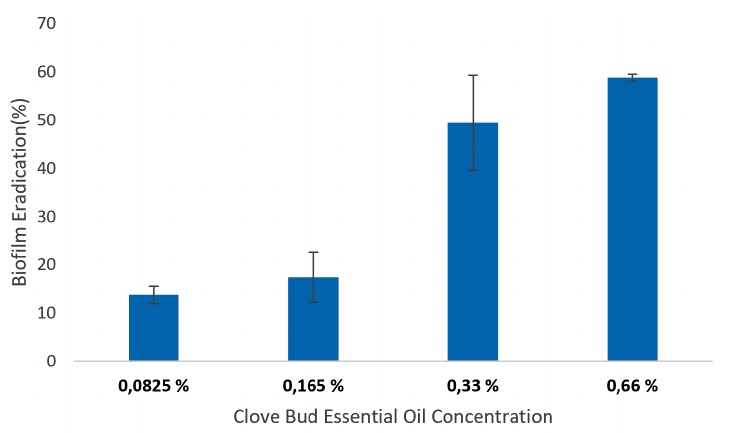
Fig. 2. MBEC assay of clove bud essential oil microemulsion. The highest concentration evaluated did not result in 100% biofilm elimination